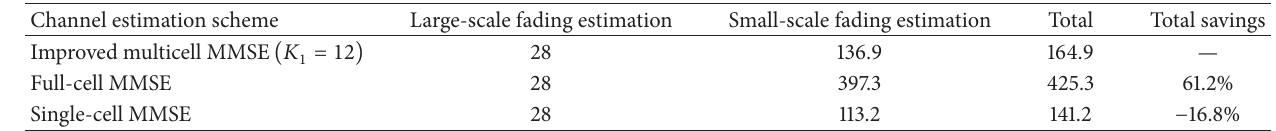
Table 4: Comparison of computational cost (unit: